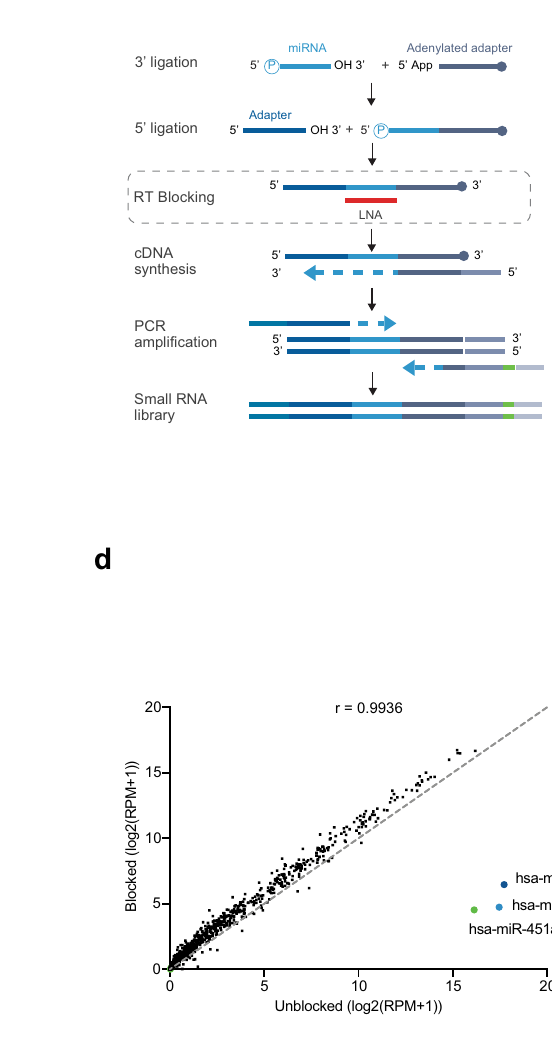
Following miRisk strati fi cation of patients in the control cohort we observed no signi fi cant difference in survival between those in the low-risk versus high-risk groups (HR 1.36, 95% CI 0.72 – 2.57; P = 0.37) (Fig. 2c). Similarly, we observed no signi fi cant prediction of 6 month survival with the miRisk score in the control cohort using the time-dependent ROC analysis (Fig. 2i). The interpretation of these results is, however, limited by the potential mixed effects of concurrent treatment with immunotherapy and chemotherapy, and the shorter duration of patient follow-up relative to the other study cohorts. Still, in these real-world clinical cohorts, these results provide evidence of miRisk as a predictor of survival following immunotherapy monotherapy.